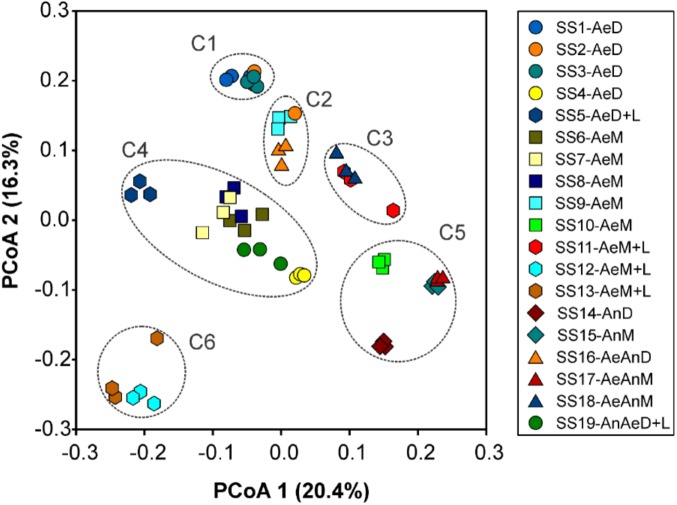
Principal coordinate analysis (PCoA) for bacterial community structure of 19 sewage sludges from São Paulo State, Brazil (n = 3). Axis values indicated percentage of variance.